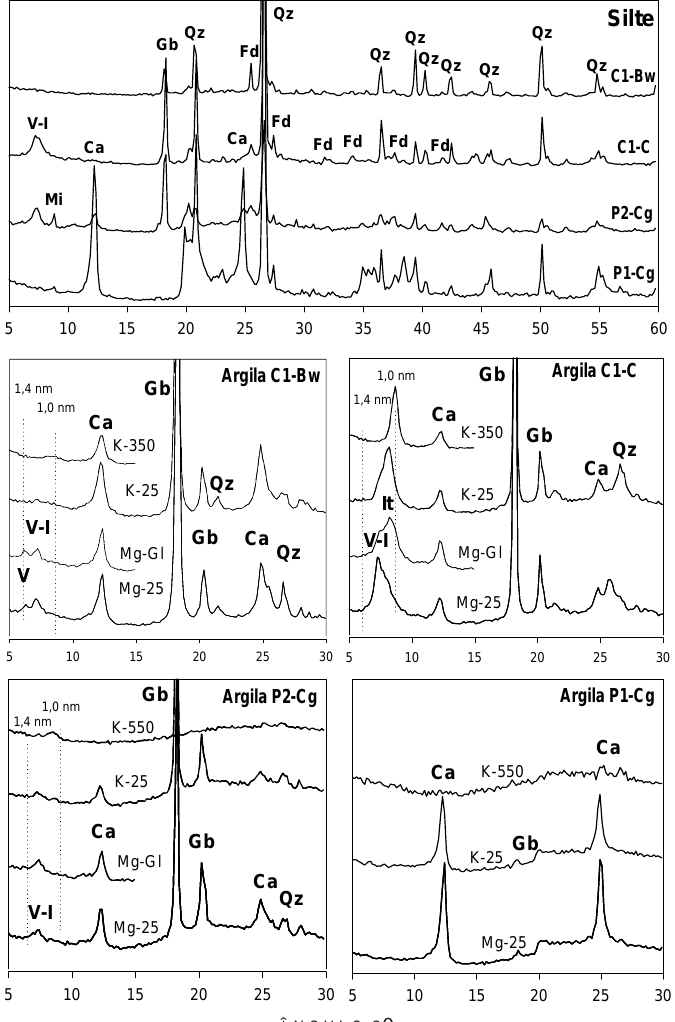
Figura 6. Difratogramas de raios-X da fração silte e argila deferrificada, sendo: Ca = caulinita, Fd = feldspatos; Gb = gibbsita; I-V = ilita-vermiculita; It = ilitas; Mi = micas; Qz = quartzo; V = vermiculitas; V-I =